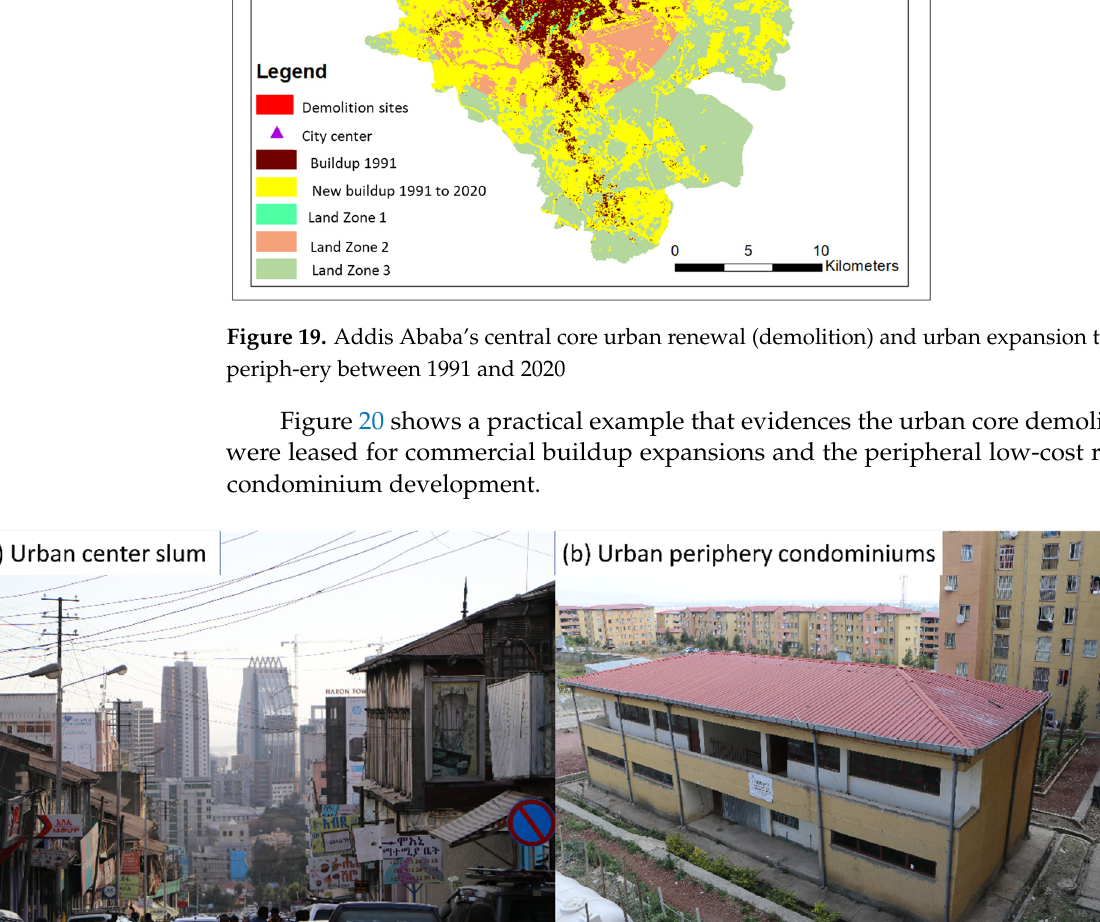
Figure 20. The city slum demolition and replacement with the emerging commercial buildups at the center ( a ) and low-cost condominium housing expansions at the urban periphery ( b ). Source: cap-